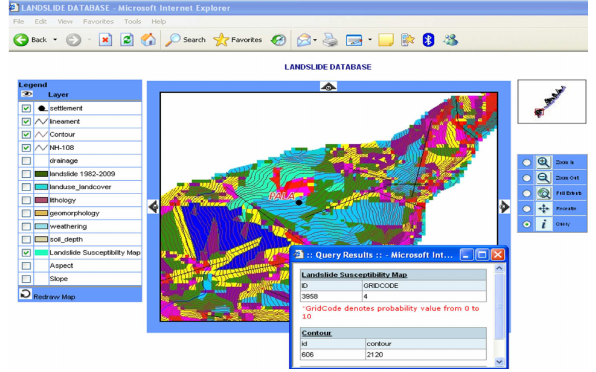
Figure 5. Landslide susceptibility map and contour information displayed on a web